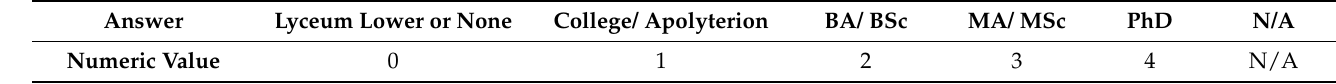
Table 3. Numeric values for Educational level (D2) of participants.